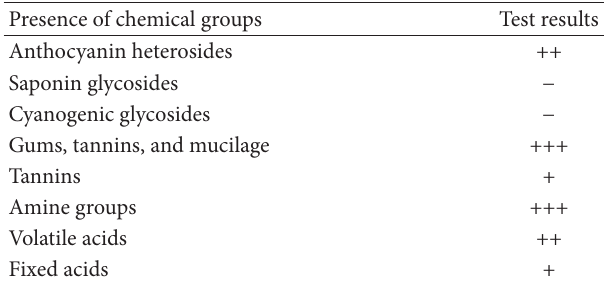
Table 5: Tests for the aqueous fruit extract of Solanum sessiliflorum